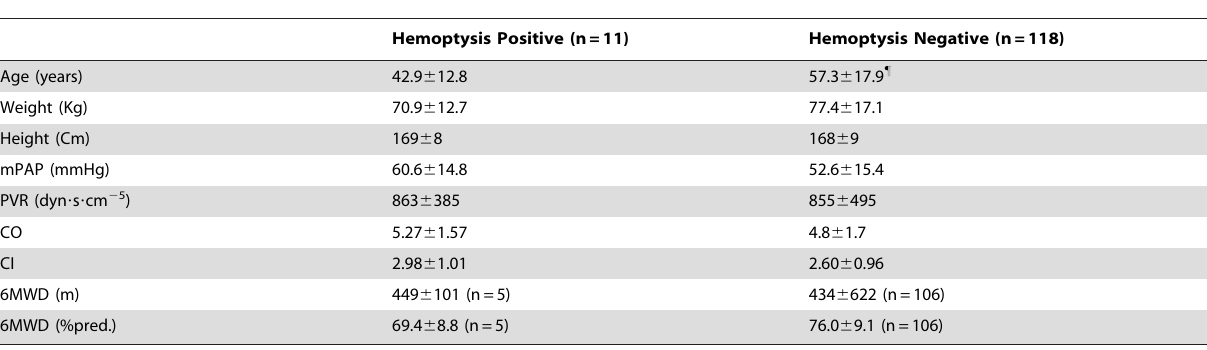
Table 1. Baseline demographics and hemodynamics of the study population.